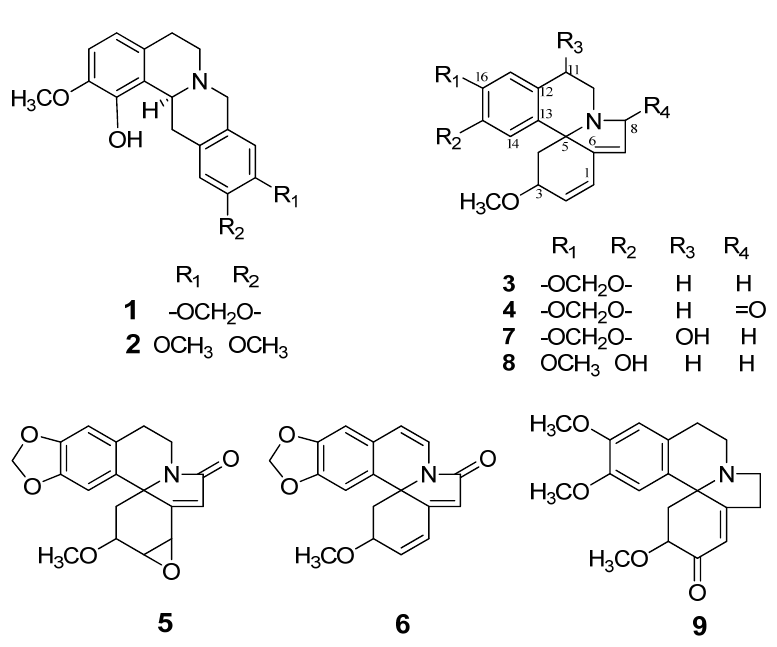
Figure 1. Structures of alkaloids 1 – 9